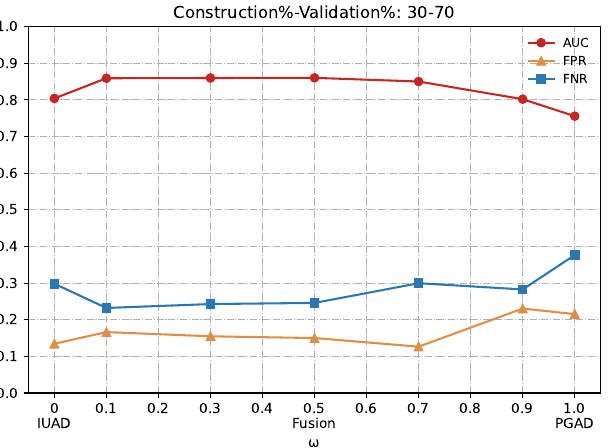
Figure 10. Detection results of the IUAD, the PGAD and the fusion model in terms of AUC, FPR, FNR (User’s http records division based on Construction%–Validation%: